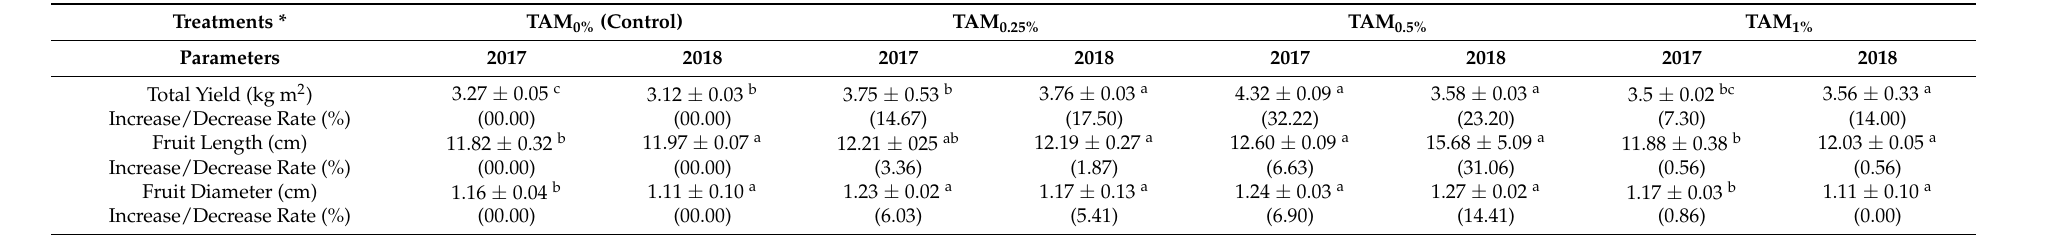
Table 5. The effect of different TAM ® levels on fruit characterizations of C. annuum, during 2017 and 2018 growing